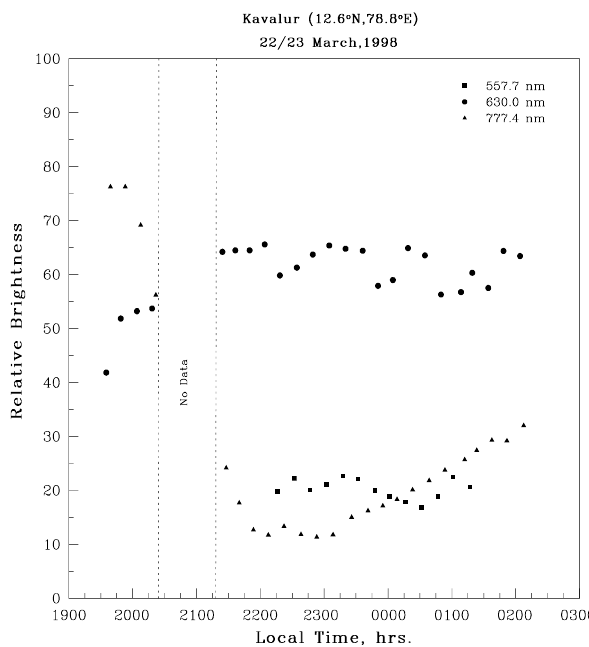
Fig. 13. Variation in the relative brightness of the airglow enhance- ments in an area of 50 × 50 pixels approximately located at the center of the brightness pattern on the night of 22/23 March